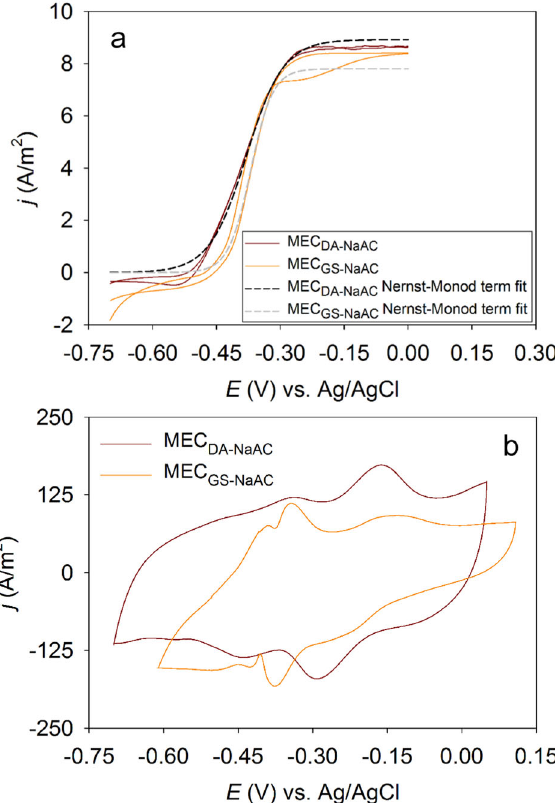
Fig. 2 Slow scan (1 mV/s) cyclic voltammetry (CV) of D. acetexi- gens (ME CDA-NaAc ) and G. sulfurreducens (ME CGS-NaAc ) bio fi lms developed under a set anode potential of − 0.1 V vs. Ag/AgCl for ~200 h. a CV recorded in the presence of 6 mM of acetate as the sole electron donor. The dashed curve lines in a represent the Nernst – Monod model fi t for n = 1. b CV behavior of both bio fi lms under non-turnover conditions in the growth medium (lacking